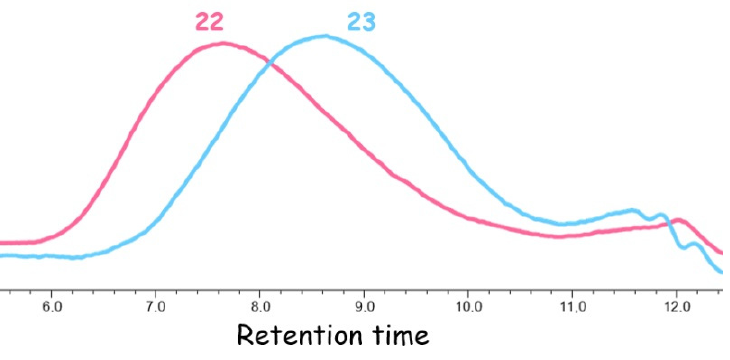
Figure 8. GPC curves obtained in Experiments 22 —L-PPSQ with silanol groups blocked by trimethylchlorosilane; 23 —condensation product of sample 22 with addition of water.